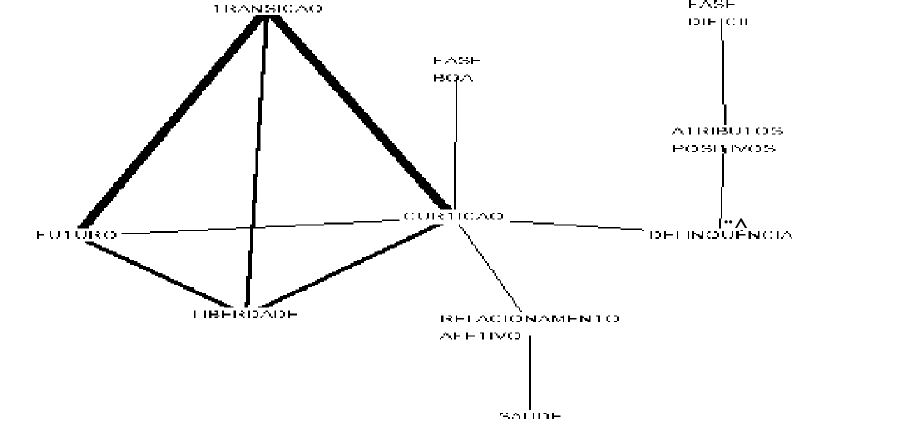
Figura 4. GrÆfico de anÆlise de similitude das categorias relacionadas (cid:224) adolescŒncia entre os sujeitos do interior ( n